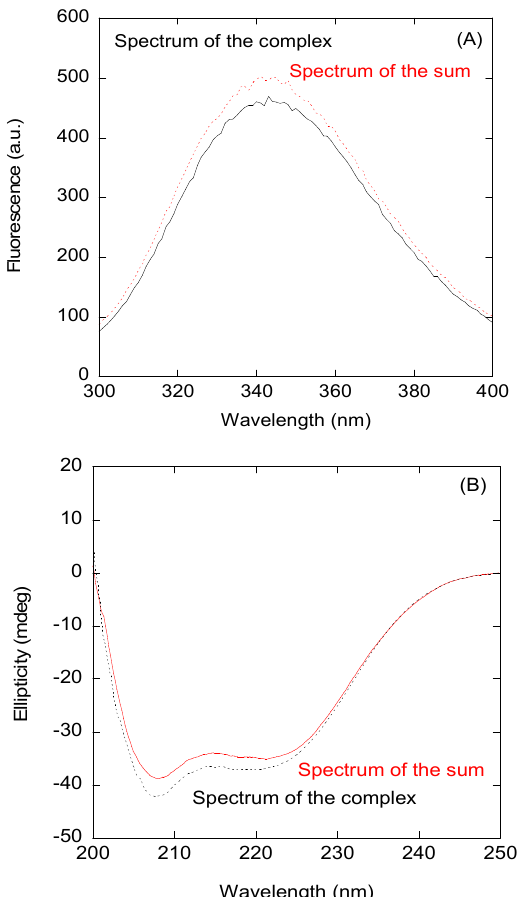
Figure 2. Binding of the wild-type (wt) peptide to importin α 3 (Imp α 3) monitored by spectroscopic techniques: ( A ) Fluorescence spectrum obtained by excitation at 280 nm of the complex between Imp α 3 and the wt peptide and the addition spectrum obtained by the sum of the spectra of both isolated macromolecules. ( B ) Far-UV CD (ultraviolet circular dichroism) spectrum of the complex between the Imp α 3 and wt peptides and the additional spectrum obtained by the sum of the spectra of both isolated macromolecules.